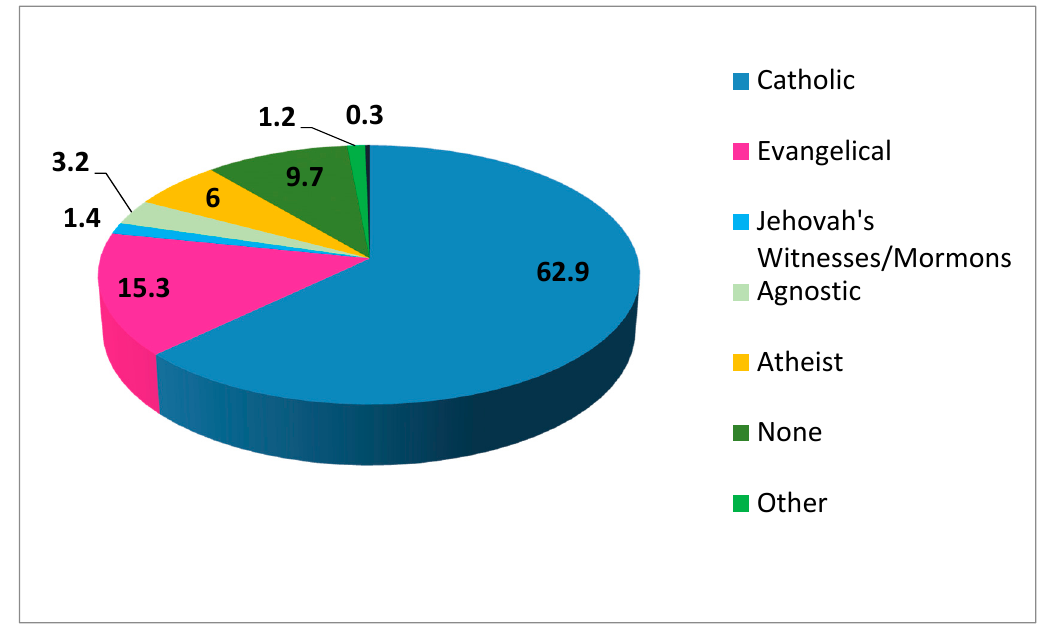
Figure 1. Religious affiliation (in %). Based on 2421 cases. Source: Second national survey on religious beliefs and attitudes. Society, Culture and Religion Programme, CEIL-CONICET, 2019.